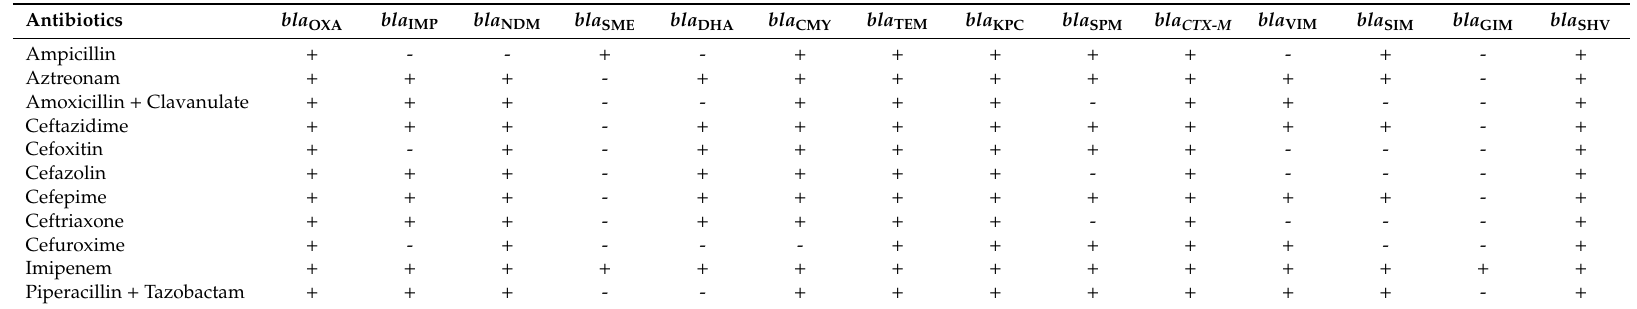
Table 3. Bibliographical survey concerning the phenotypic resistance of beta-lactamases against the corresponding resistance genes. subtitle: the ( + ) sign indicates a correlation in the literature of the corresponding beta-lactamase coding gene of the column, with the corresponding antibiotic in the horizontal line. while the (-) sign indicates an absence of correlation in the gene and antibiotic